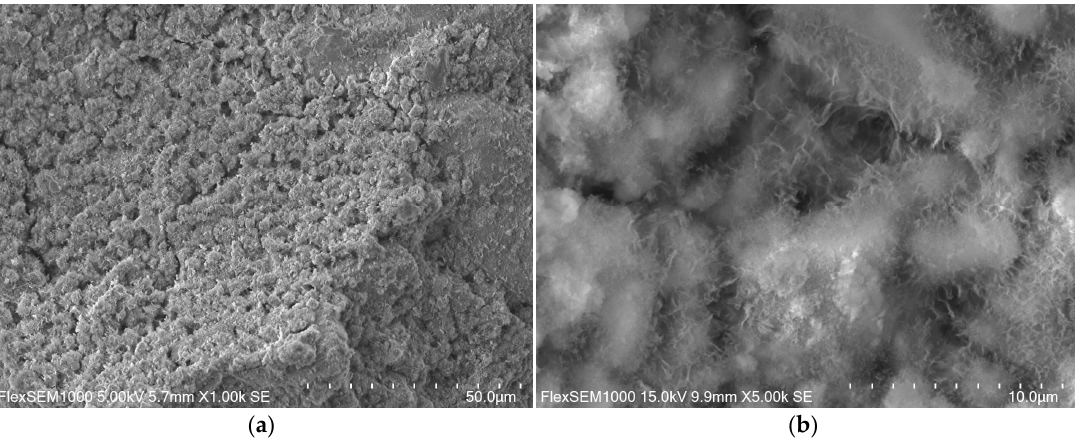
Figure 8. ZK1 microstructure prepared in magnification of: ( a ) 1000×; ( b ) 500×.